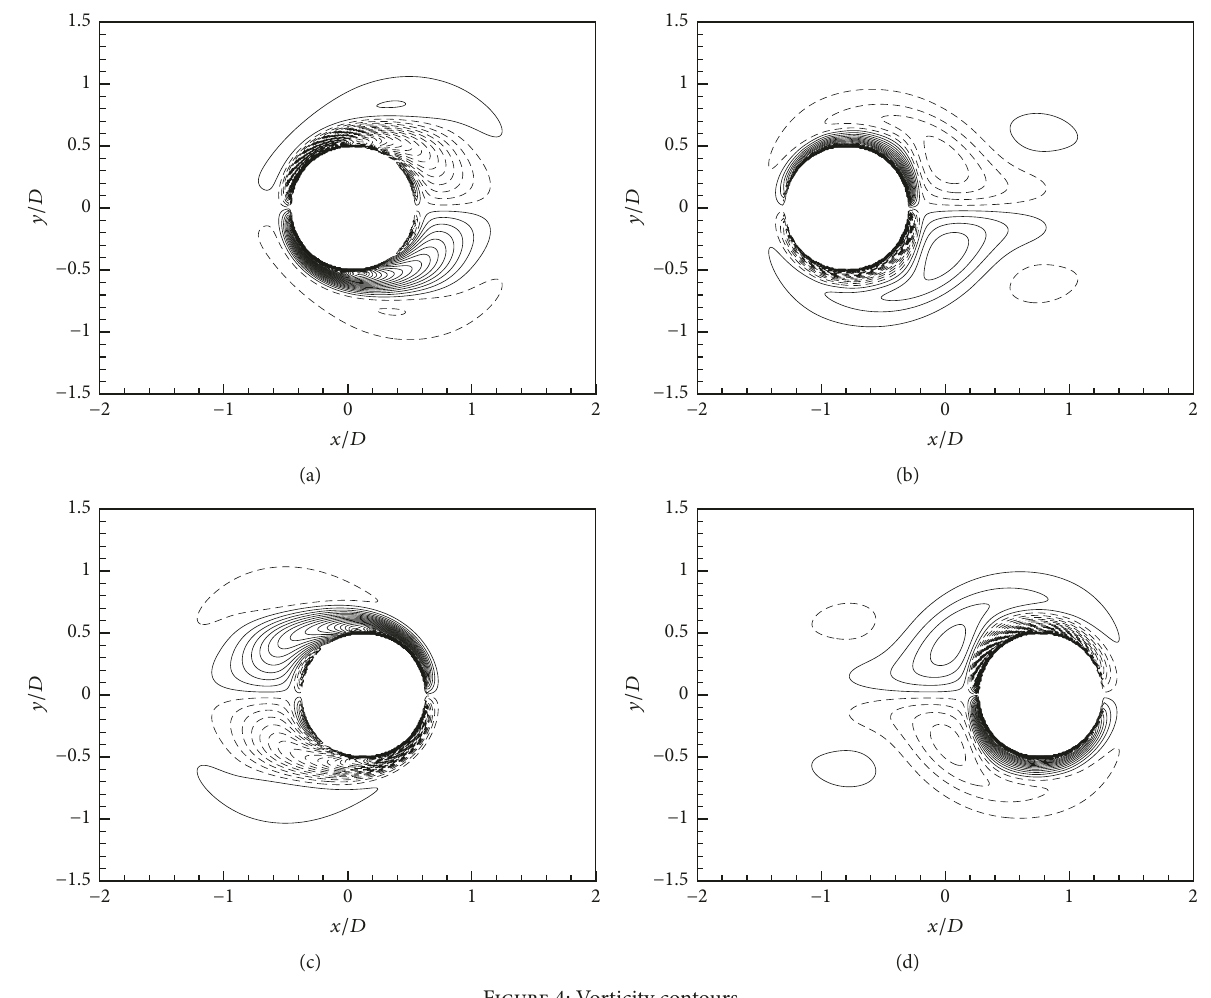
Figure 4: Vorticity